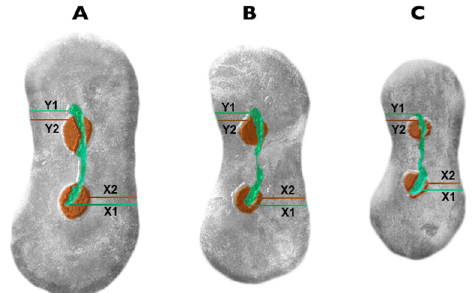
Figure 1. Cross-sectional images representing reference points of measurements before (greenish) and after (reddish) root canal shaping at the level of 9 ( A ), 6 ( B ) and 3 mm ( C ) from the apex subsequently. X1 represents the shortest distance from the mesial edge and the Y1 from the distal edge of the unprepared root canal to the appropriate edge of the root. X2 and Y2 represent the shortest distance from the mesial and distal edge of the prepared root canal to the relevant edge of the root [19].